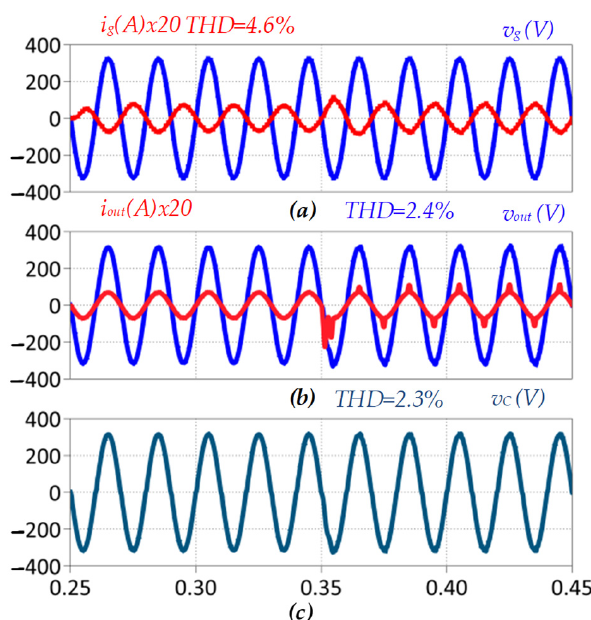
Figure 8. Voltage and current shape at the main grid ( a ), output ( b ), and capacitor of the filter ( c ) with k out = 1, k c = 0 .